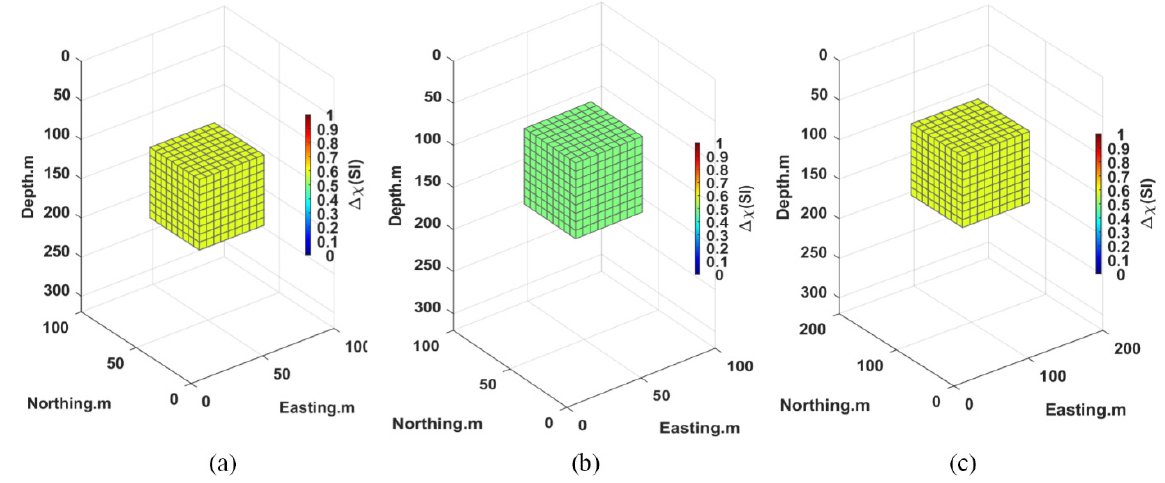
Figure 9. Comparison of inversion results. ( a ) Input model: Rectangle; ( b ) B xx and B yy inversion result; and ( c ) B xy , B xz , B yz and B zz inversion result.